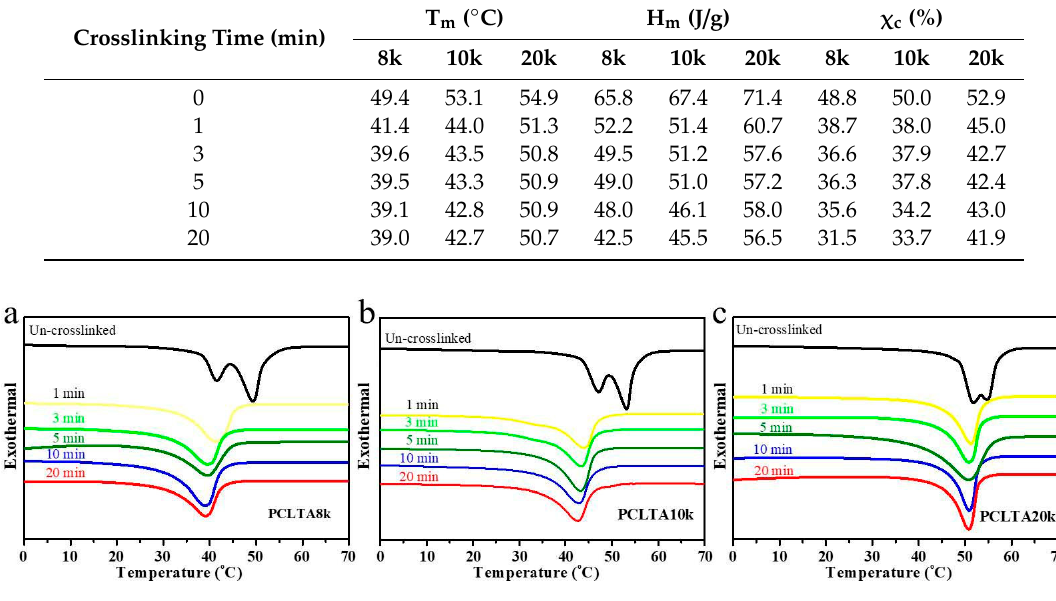
Figure 2. Differential scanning calorimeter (DSC) curves of crosslinked PCLTA8k ( a ), PCLTA10k ( b ), and PCLTA20k ( c ) with different crosslinking time. Table 1. Thermal properties of the crosslinked PCLTAs with different crosslinking time.